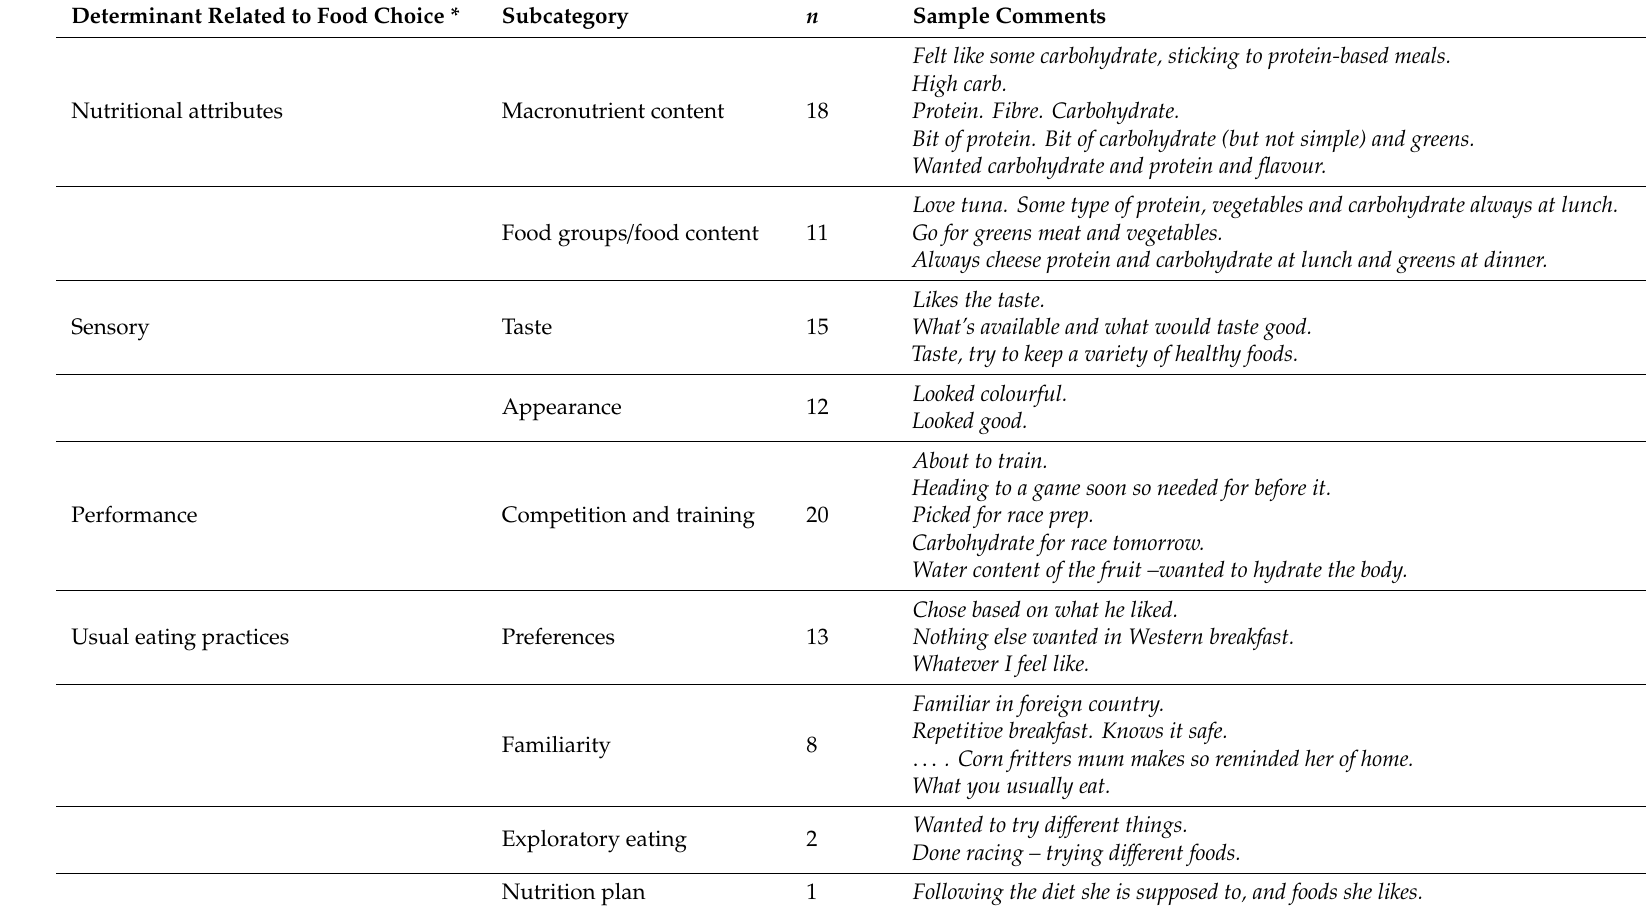
Table 4. Participants’ self-reported reasons for selecting